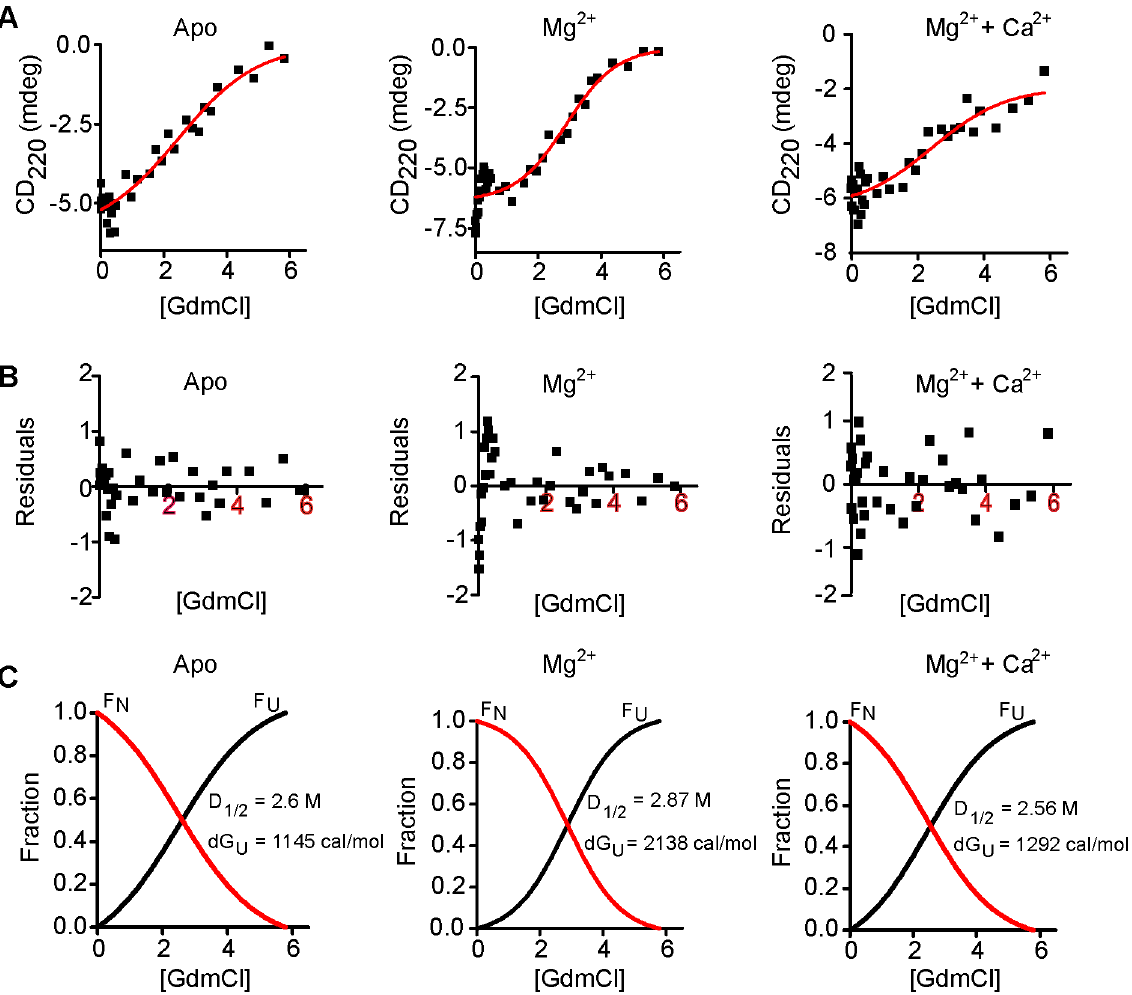
Figure 4. Equilibrium chemical unfolding. Equilibrium chemical unfolding of full length Caldendrin with guanidinium hydrochloride (GdmCl) in the absence of any ligand (Apo-CDDfl), in presence of 5 mM MgCl 2 and 1 mM EGTA (Mg 2 + -CDDfl); and 5 mM MgCl 2 and 1 mM CaCl 2 (Mg 2 + Ca 2 + - CDDfl). The upper lane shows (A) the ellipticity values of plotted against [GdmCl] (black squares) and the fitting obtained (black curve) using a two- state unfolding model. The middle lane (B) shows the quality of model fitting in terms of residuals and the bottom lane (C) shows the normalized fits for fraction folded (FN; red curve) and fraction unfolded (FU; black curve) along with the standard free energy change of unfolding ( D GU) obtained.